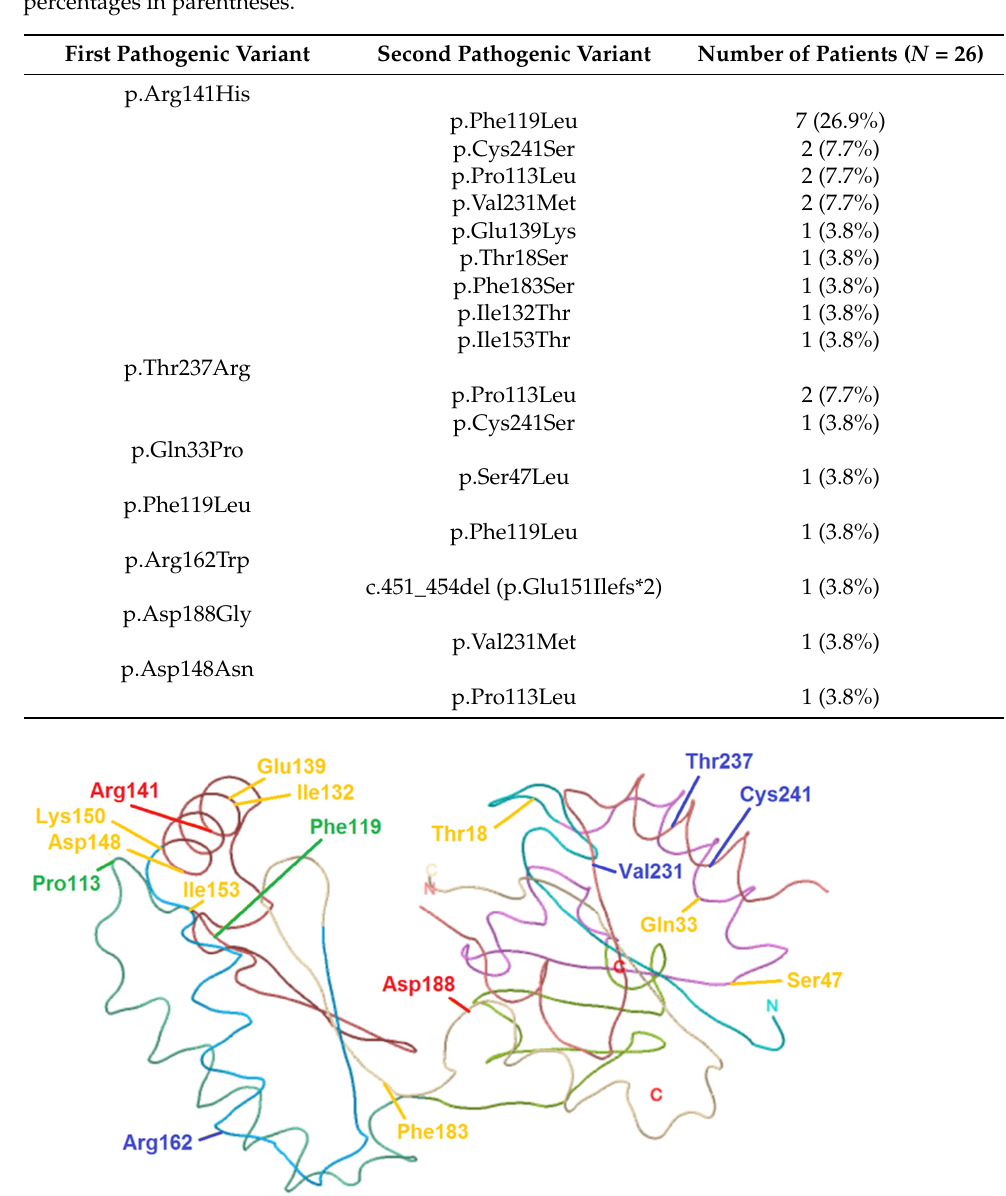
Figure 1. Structure of PMM2 protein and the changes described in this study. Residues involved in the catalytic site are indicated in red, dimerization residues are highlighted in green and lastly, folding residues are depicted in blue. The remaining residues, highlighted in yellow, could not be classified into these previous groups as their function is not fully known or they have a different functioning